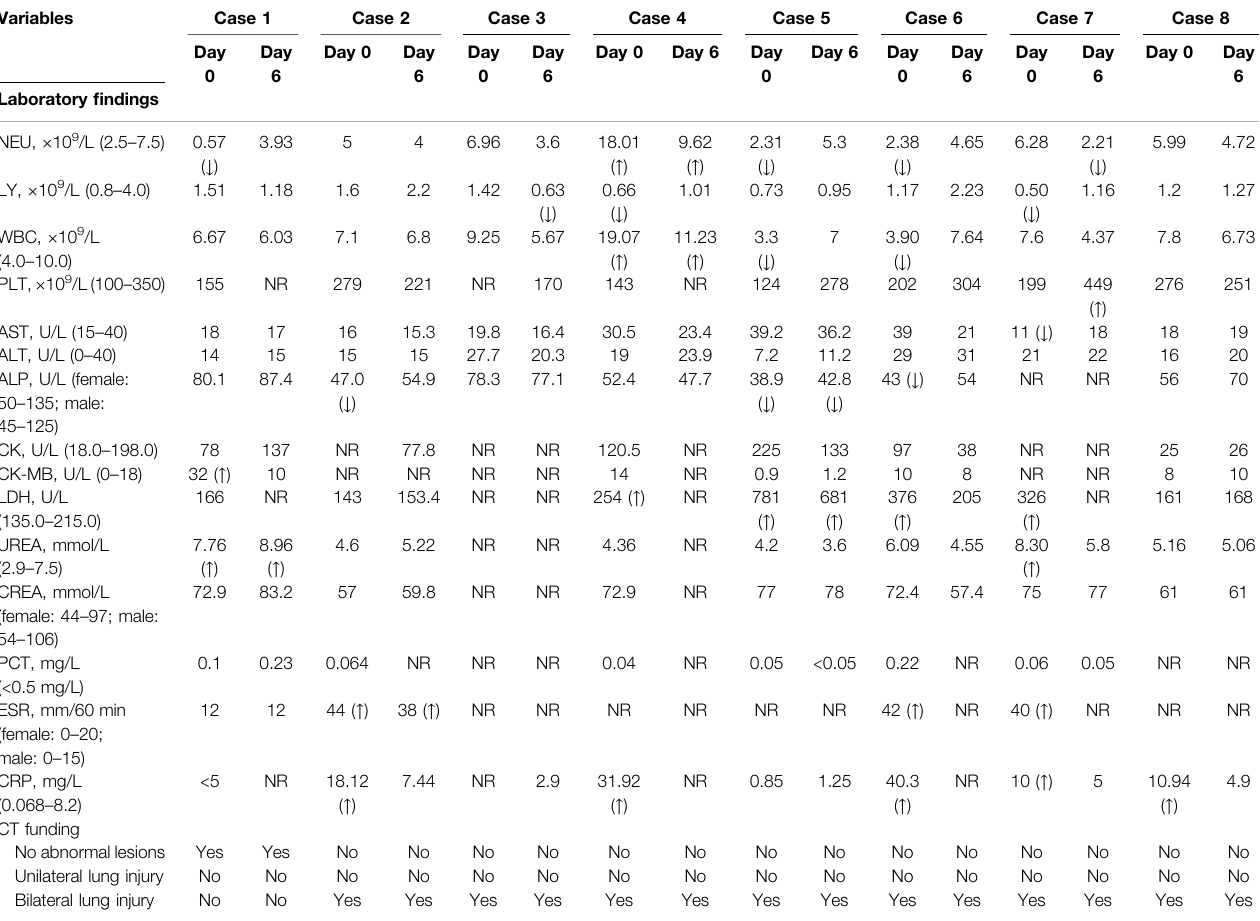
TABLE 4 | Laboratory and CT fi ndings of eight COVID-19 cases before and after QFPDD